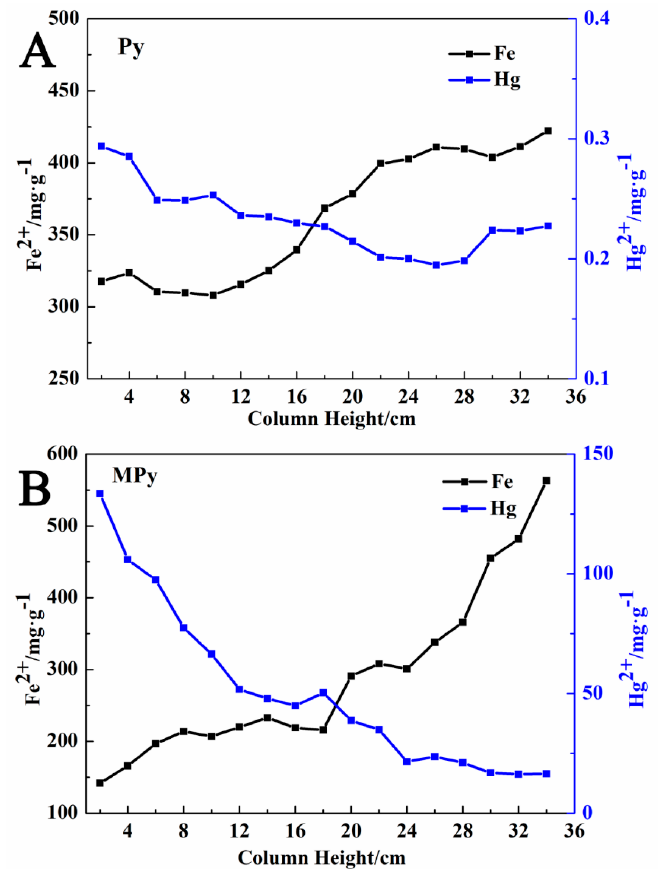
Figure 5. Variation of the Hg(II) and Fe(II) contents with respect to the column height ( A ) of the Py column and ( B ) MPy column.